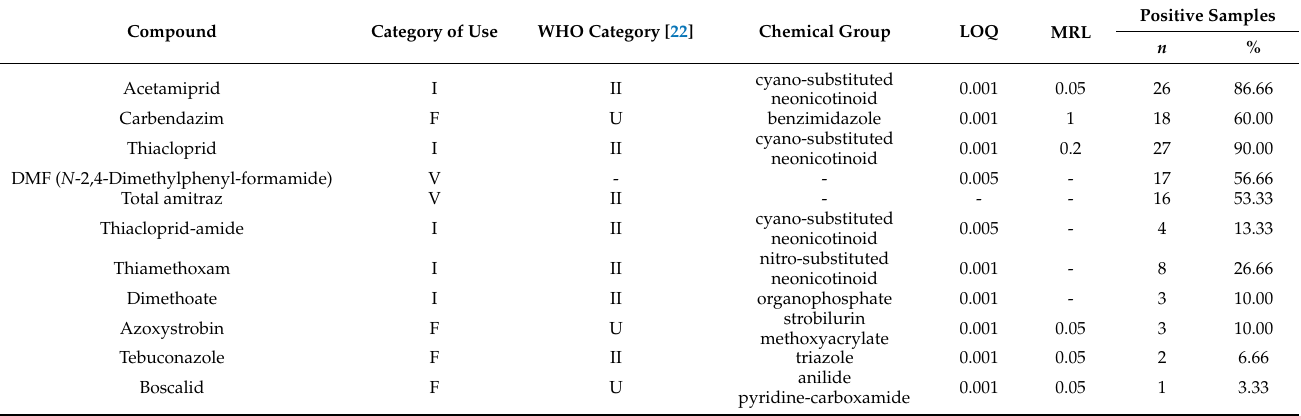
Table 2. List of substances identified in honey (V—Veterinary drugs, F—Fungicides, I—Insecticides; II—Moderately hazardous, U—Unlikely to present acute hazard; LOQ—Limit of quantification (mg/kg), MRL—Maximum residue level